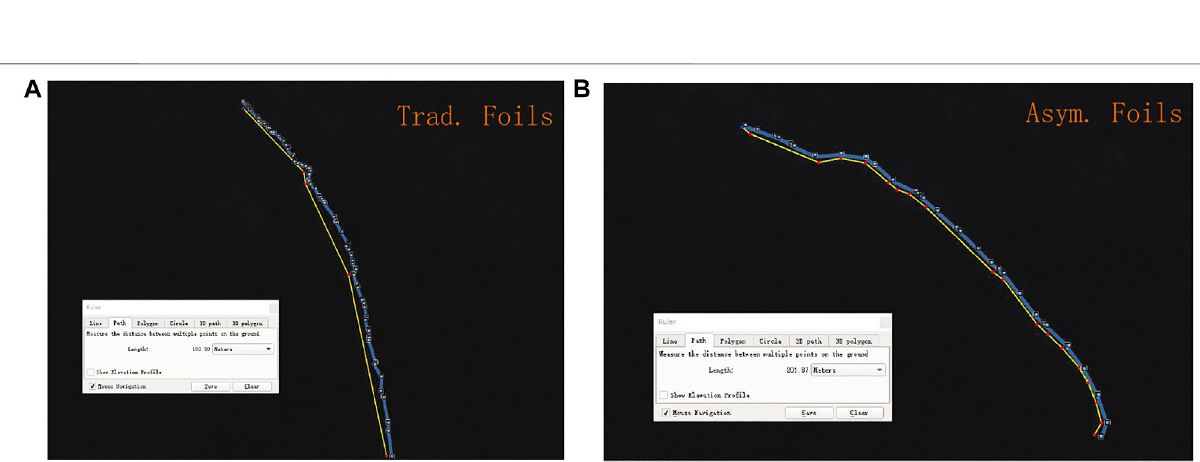
Frontiers in Robotics and AI |